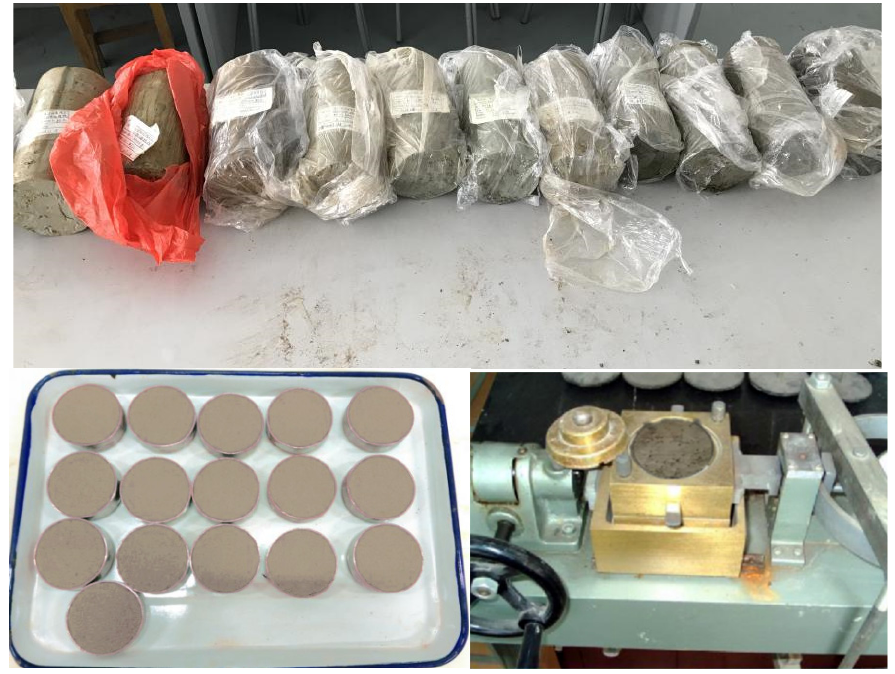
Figure 1. Strength test of the undisturbed soil sample.